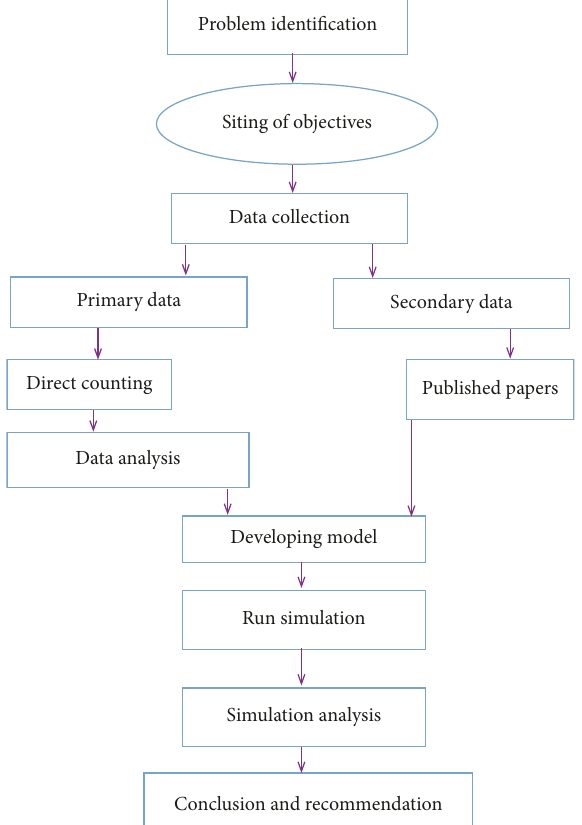
Figure 1: Data collection, model creation, and research completion steps in the research